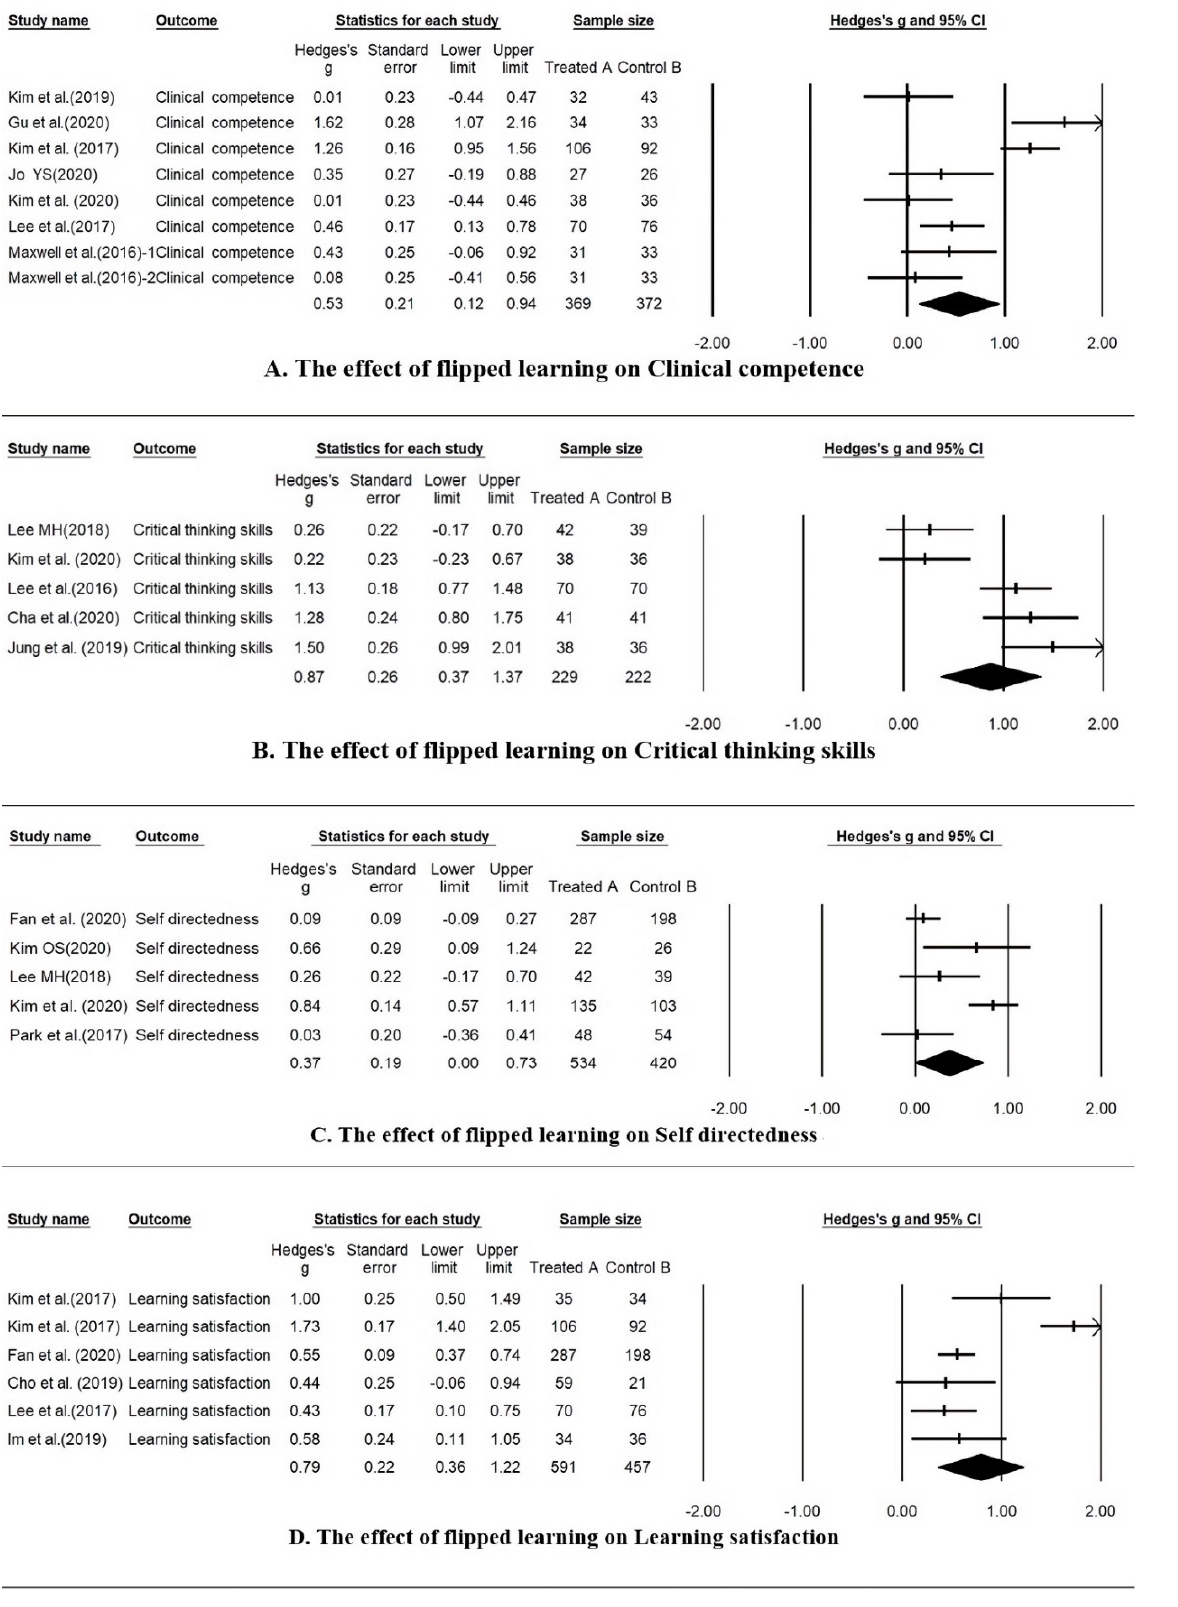
Figure 2. Forest plot of effect size of flip learning for nursing students. The heterogeneity of the total effect size was I 2 = 90.7% (Q = 246.67, p < 0.001), appear- ing to fall within a large range [18]. The effect size of each effect variable of the flipped learning intervention was statistically significant because the 95% CI excluded 0, and the